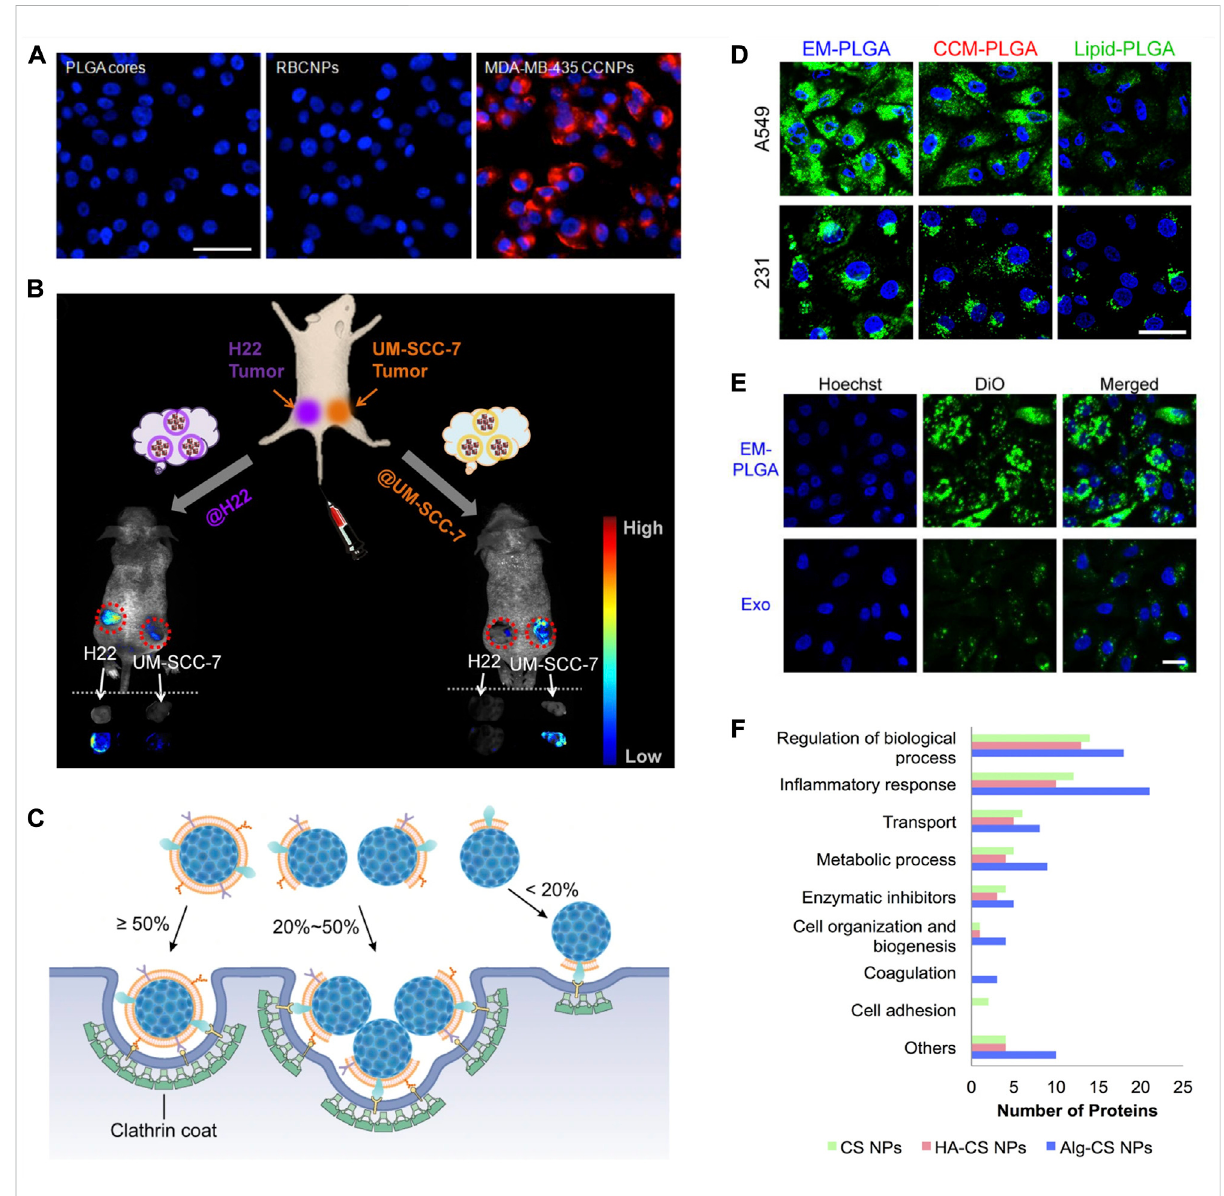
FIGURE 2 Biological membranes and biomolecules of surface modi fi cation. (A) Fluorescent imaging of MDA-MB-435 cells incubated with PLGA cores, RBCM-coated PLGA NPs (RBCNPs), or MDA-MB-435 tumor CM-coated NPs (CCNPs). NPs were labeled with DiD (red) and nuclei were stained with DAPI (blue). Scale bar, 50 μ m. Reprinted with permission from Fang et al. (2014). Copyright 2014 American Chemical Society. (B) Schematic illustrationof the invivo study with H22 and UM-SCC-7 dual-tumor-bearingmouse model.Fluorescenceimages and exvivo images oftumors at 12 h post injection with H22 and UM-SCC-7 tumor CM-coated magnetic NPs. Reprinted with permission from Zhu et al. (2016). Copyright 2016 American Chemical Society. (C) Illustration of different cell internalization strategies by NPs with different CM coating percentages by Liu et al. (2021)licensedunderCCBY4.0. (D) Confocal fl uorescenceimagesofcellularuptakeofA549cell-derivedEM-coated(EM-PLGA),A549cancerCM- coated (CCM-PLGA), and lipid-coated (lipid-PLGA) PLGA NPs by A549 and MDA-MB-231 (231). The PLGA cores were labeled with DiO (green), and thecellnucleiwerestainedwithHoechst(blue).Scalebar,20 μ m. (E) Confocal fl uorescenceimagesshowinghighercellularuptakeofEM-PLGANPs compared to exosomes (Exo) by A549 cells. The membranes of EM-PLGA NPs and Exo were labeled with DiO (green). The cell nuclei were stained with Hochest (blue). Scale bar, 40 μ m; Reprinted with permission from (C. Liu et al. (2019)). Copyright 2019 American Chemical Society. (F) Comparison of functions of protein corona of bare chitosan NPs (CS NPs), HA-coated CS NPs (HA-CS NPs), and alginate-coated CS NPs (Alg-CS NPs) by (Almalik et al., 2017) licensed under CC BY